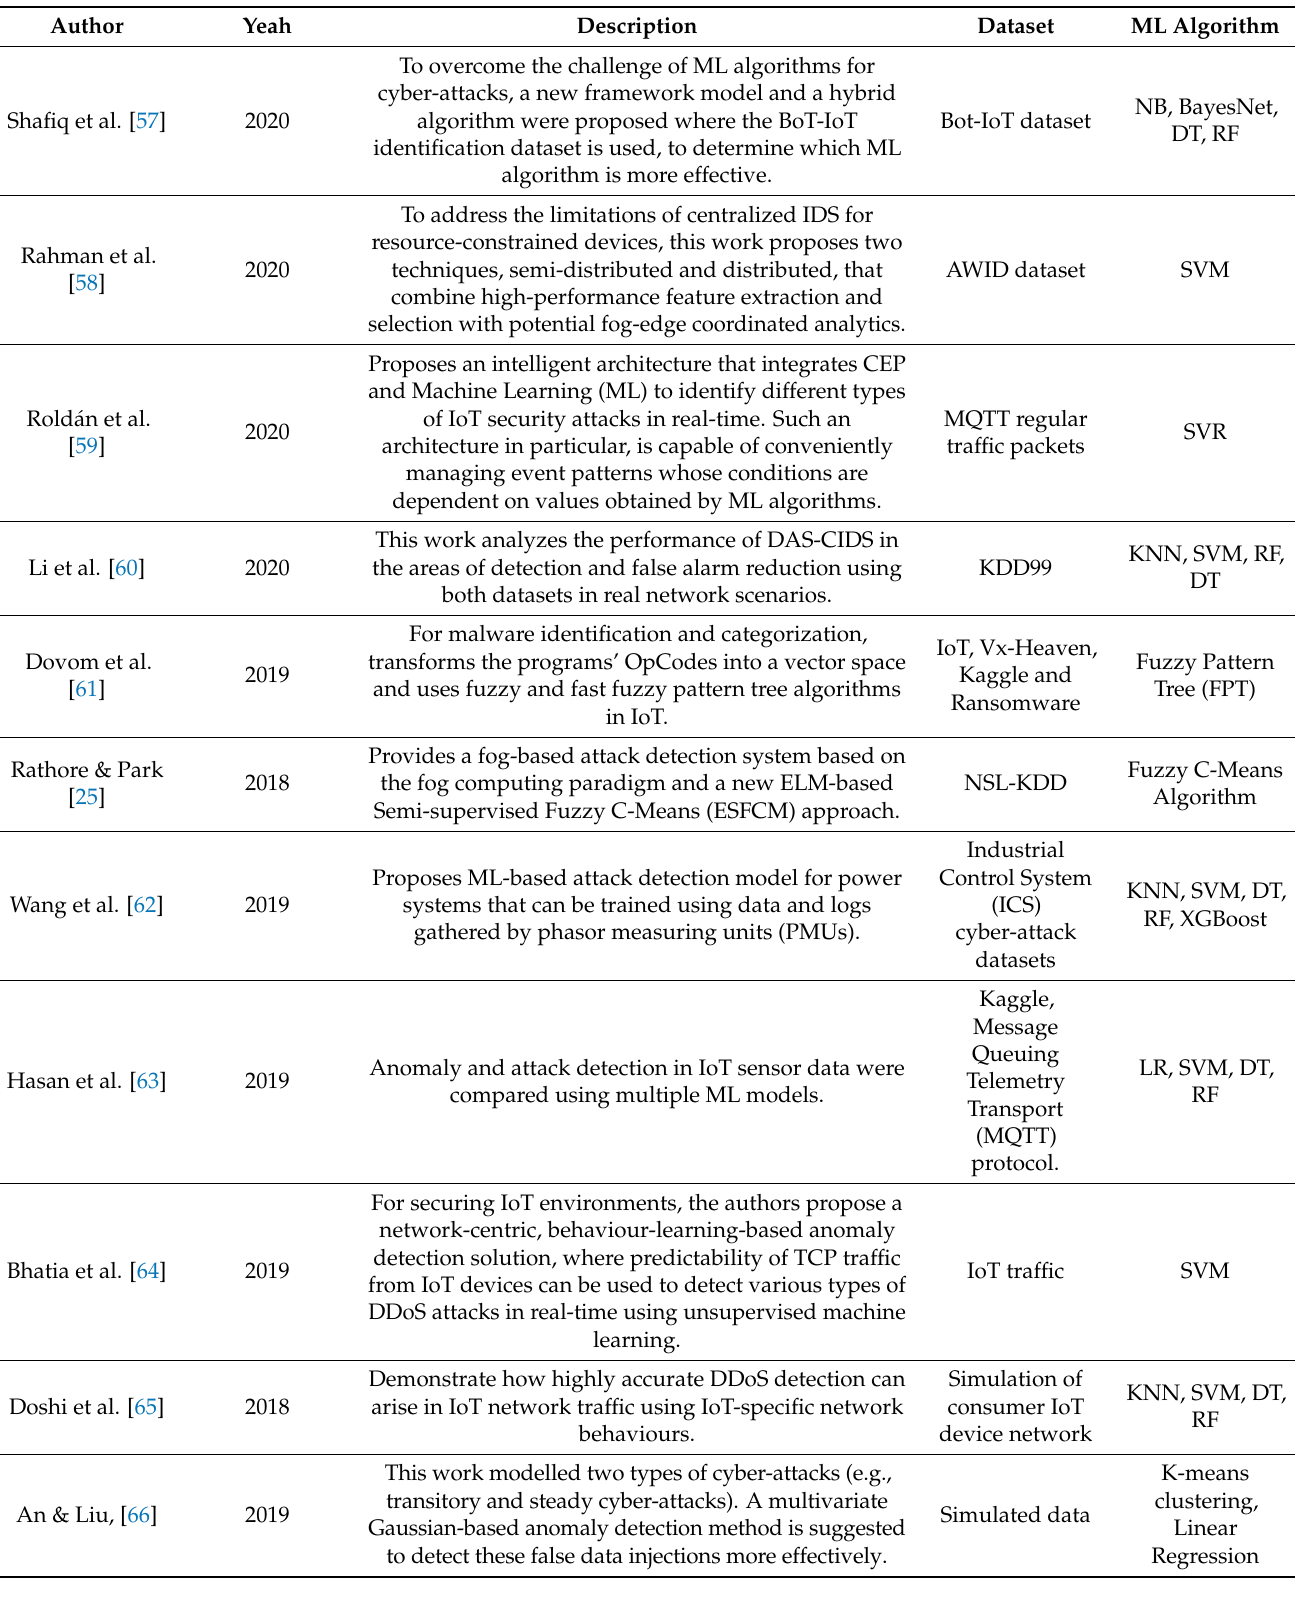
Table 4. Summary of studies classified based on ML